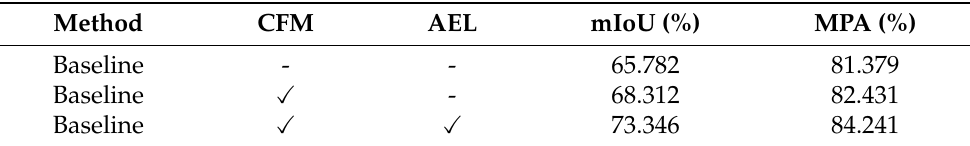
Table 3. Ablation study of FCN likewise models on Vaihingen dataset.